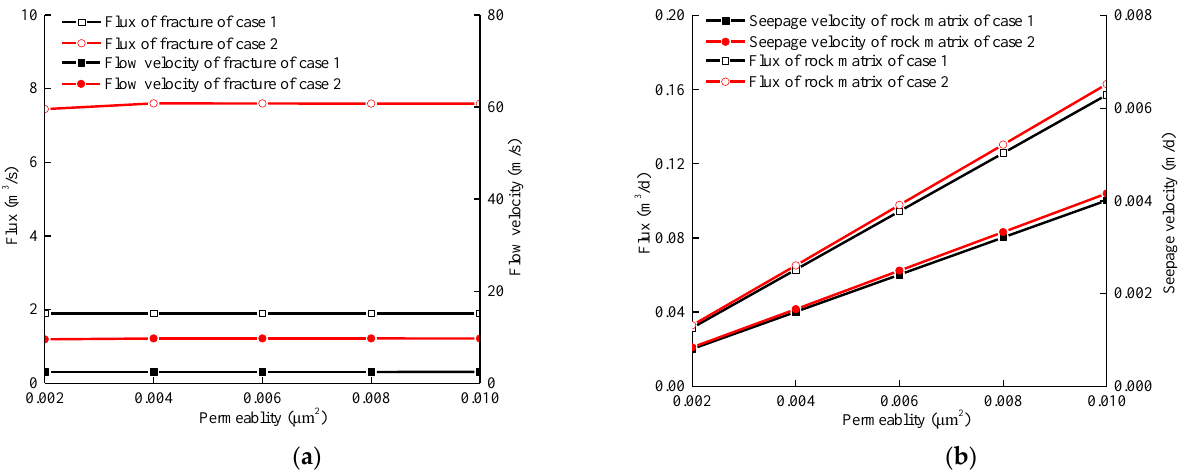
Figure 6. Velocity characteristic of fractured rock mass with different rock matrix permeability when d f = 5 mm ( ∆ H = 3 m and α = 0.3): ( a ) fracture and ( b ) rock